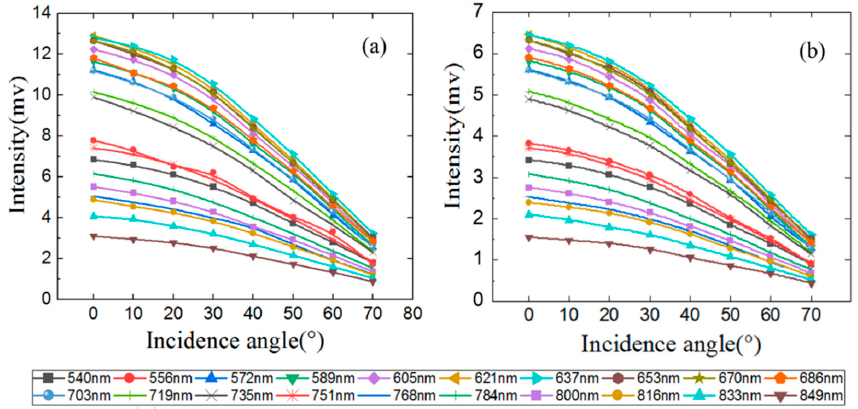
Figure 4. Backscatter intensities of twenty wavelengths of the standard reflectance panels versus incidence angle. ( a ) Raw intensities of the 99% standard reflectance panel; ( b ) raw intensities of the 50% standard reflectance panel.